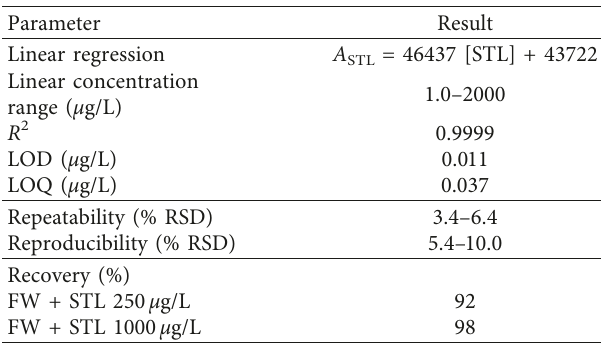
Table 1: Performance results obtained for the proposed minia- turized liquid-liquid extraction